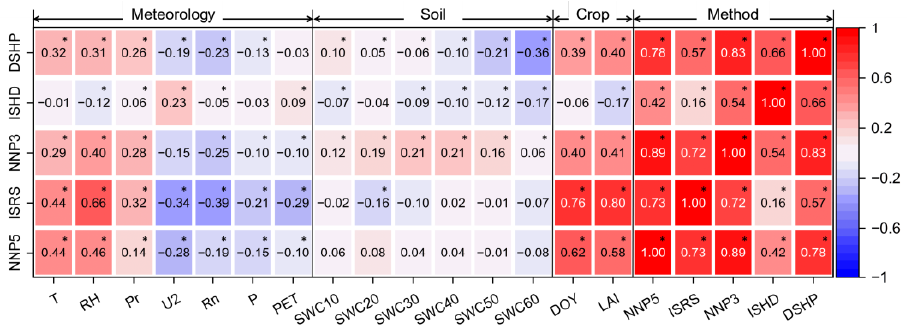
Figure 11. Correlation coefficients between the model simulated MAE and multiple indicators. * Indicates significant correlation at the 0.05 level.